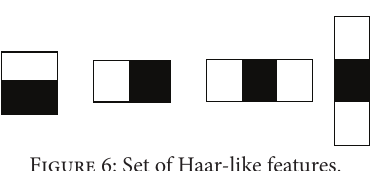
Figure 6: Set of Haar-like